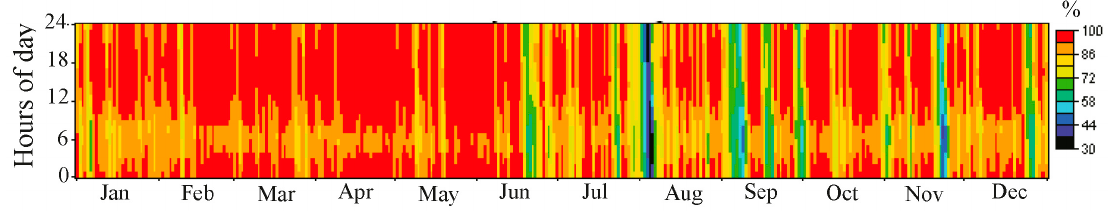
Figure 16. Monthly statistics of the SOC for the battery.